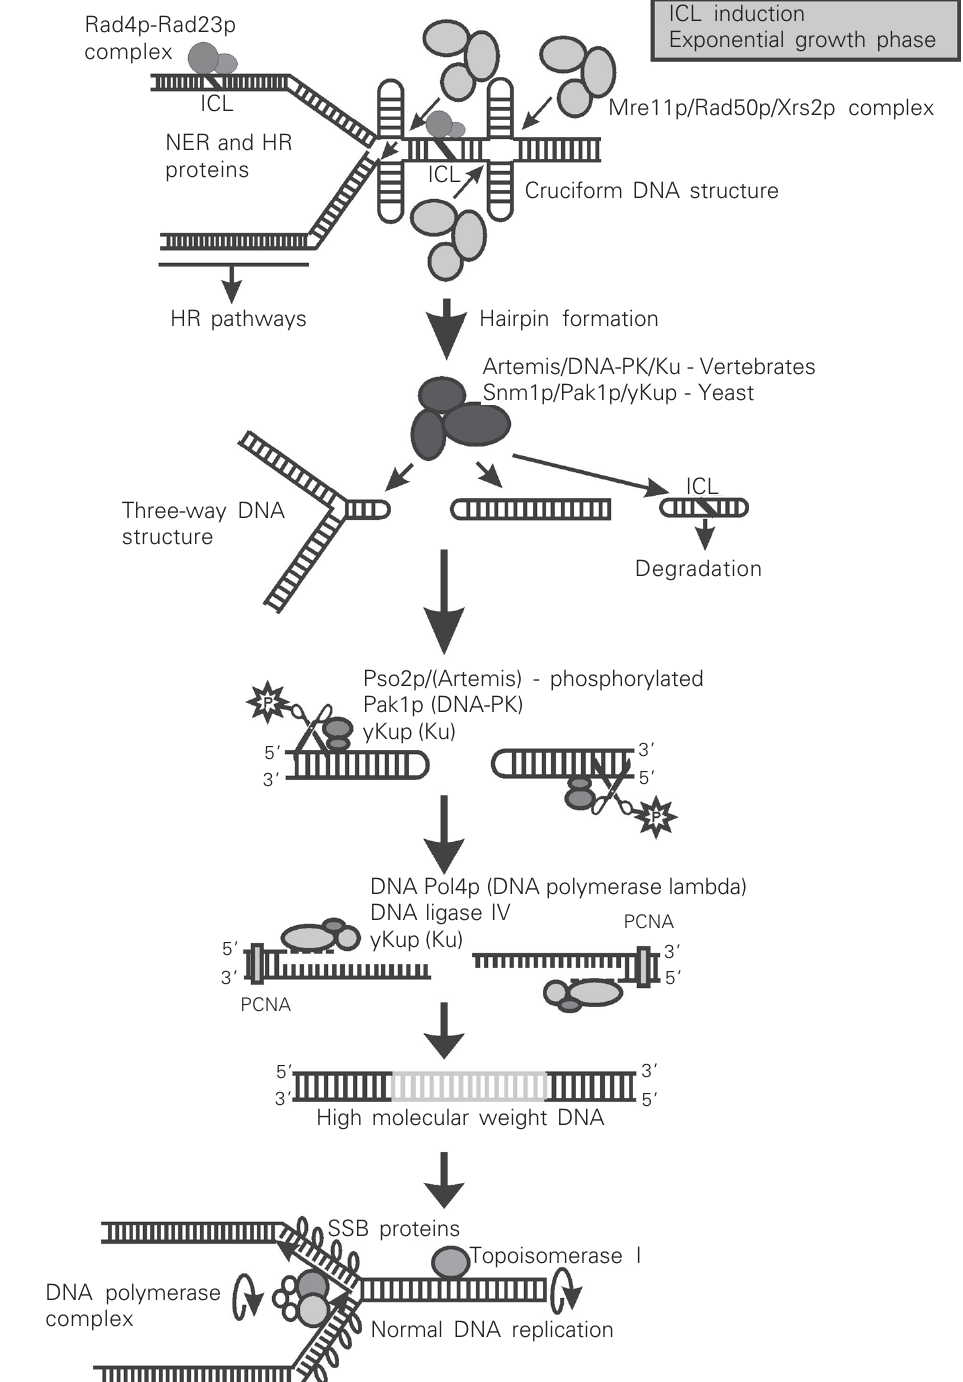
Figure 5. Non-homologous end joining recombination mediated by Snm1p/Pso2p in growing cells after inter-strand cross-link- ing (ICL) induction during DNA replication. In the presence of a sister strain, DNA repair may pro- ceed via homologous recombi- nation (HR pathways) mediated by Rad4p-Rad23p and HR pro- teins. Alternatively, the ICL can induce the formation of cruci- form DNA structures, especially when palindromic sequences are present. These cruciform structures are recognized by Mre11p/Rad50p/Xrs2p com- plex that cuts the single-strand DNA regions and induces the formation of DNA hairpins. These DNA hairpins are cleaved by the phosphorylated Artemis (Snm1p-like) DNA-PK/Ku pro- tein complex in metazoa or by phosphorylated Snm1/Pak1p/ yKup in fungi, generating a sub- strate for DNA polymerase λ (Pol4p in yeast) and DNA ligase IV, which perform, together with Ku and PCNA, the rejoining of non-homologous DNA frag- ments (gray DNA chain) and res- titute the DNA replication pro- cess. NER = nucleotide exci- sion repair; PCNA = proliferat- ing cell nuclear antigen; SSB = single-strand binding